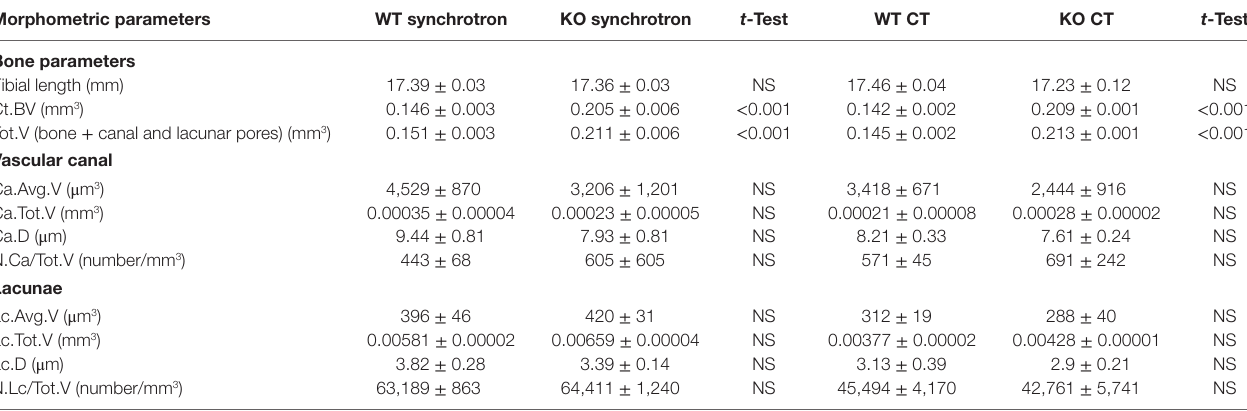
TaBle 1 | Porosity parameters representing lacuna and vascular porosity of male wild-type (WT) and Sost knockout (KO) mice at 12 weeks of age, detailing t -test comparisons for significant genotype effect of data obtained from nano-computed tomography (nanoCT) or synchrotron. Morphometric